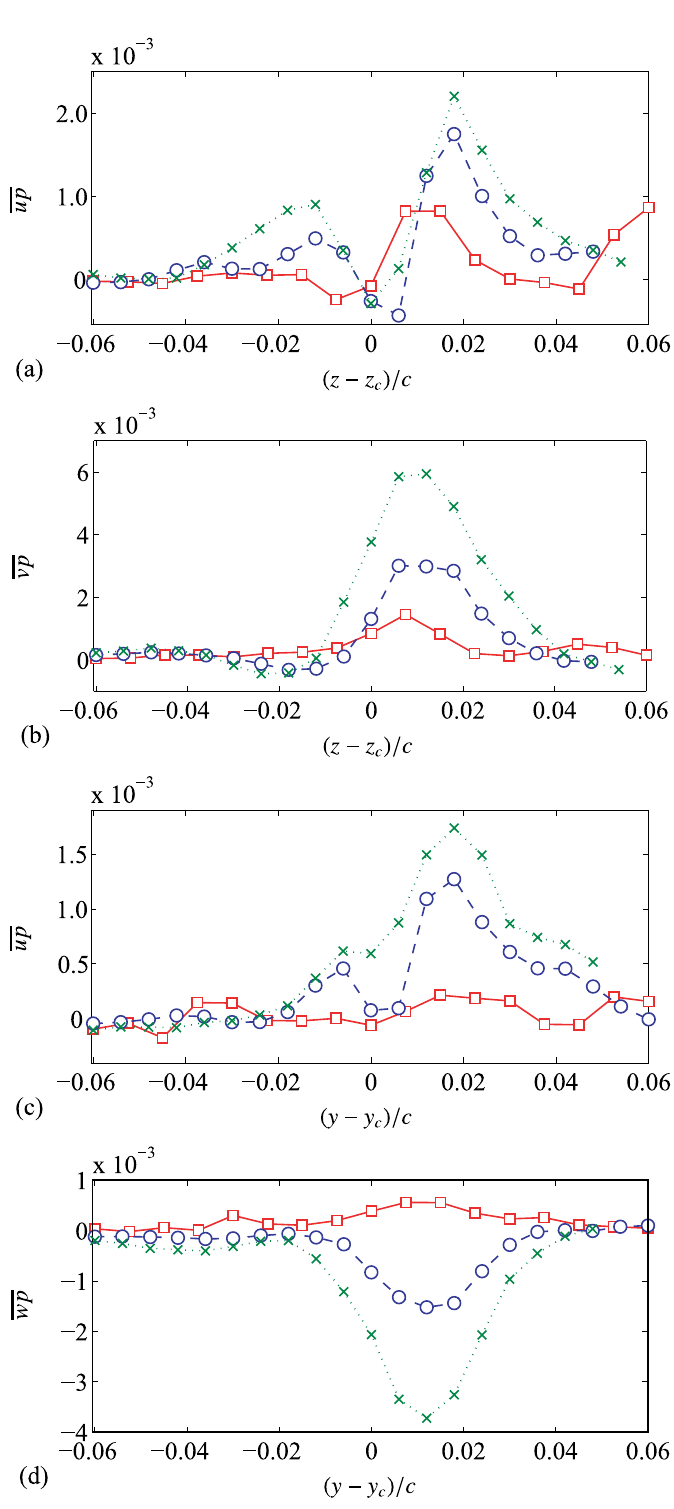
Fig. 8 Profiles of velocity-pressure correlation thorough the vortex center: (a) up ; (b) v p ; (c) up ; (d) w p (same symbols notation as Fig.